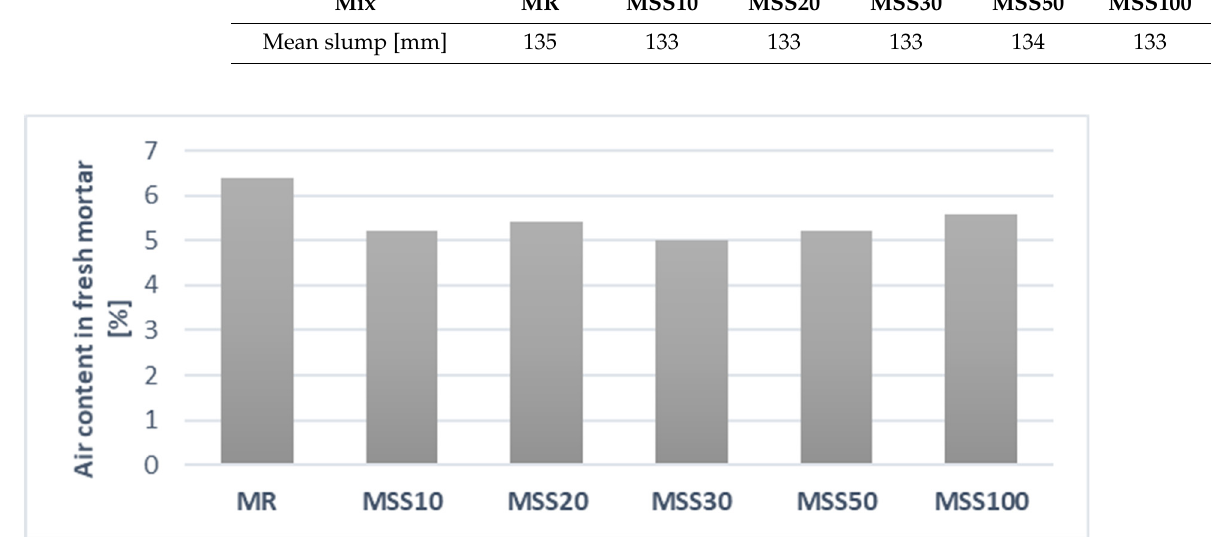
Figure 7. Slump flow determination.